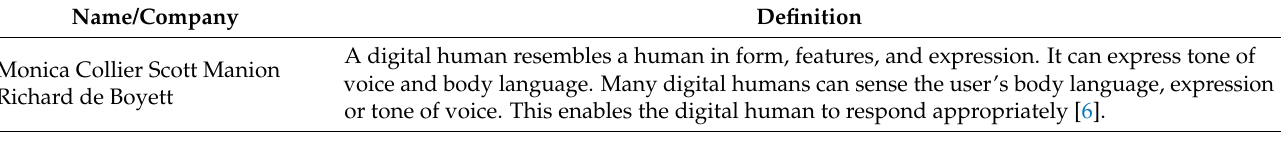
Table 1. Definition of a ‘digital